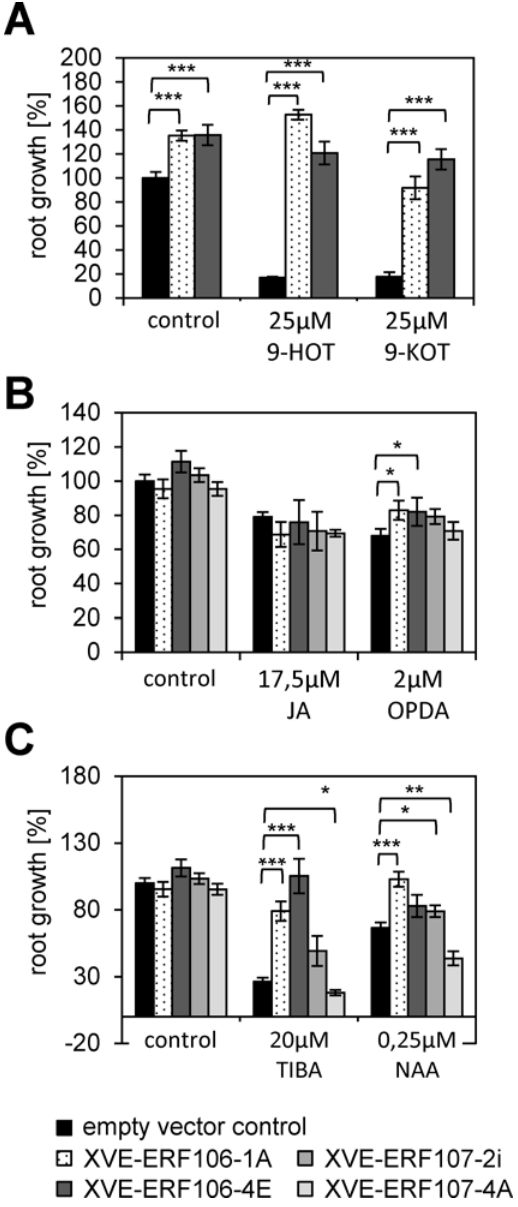
Fig 5. Root growth responses of XVE-ERF lines upon treatment with various oxylipin and xenobiotic compounds. Root growth of Est-induced XVE-ERF106 and ERF-107 lines treated or untreated (control) with the compounds indicated. (A) 9-LOX-oxylipins 9-HOT and 9-KOT, (B) JA and its precursor OPDA, (C) the xenobiotic compound TIBA and the synthetic auxin NAA. The untreated wt (Col-0) is set to 100%. Given are mean values +SE (n (cid:1) 18). The indicated differences are calculated using the student ’ s t -test: * p (cid:3) 0.05, ** p (cid:3) 0.01, *** p (cid:3)